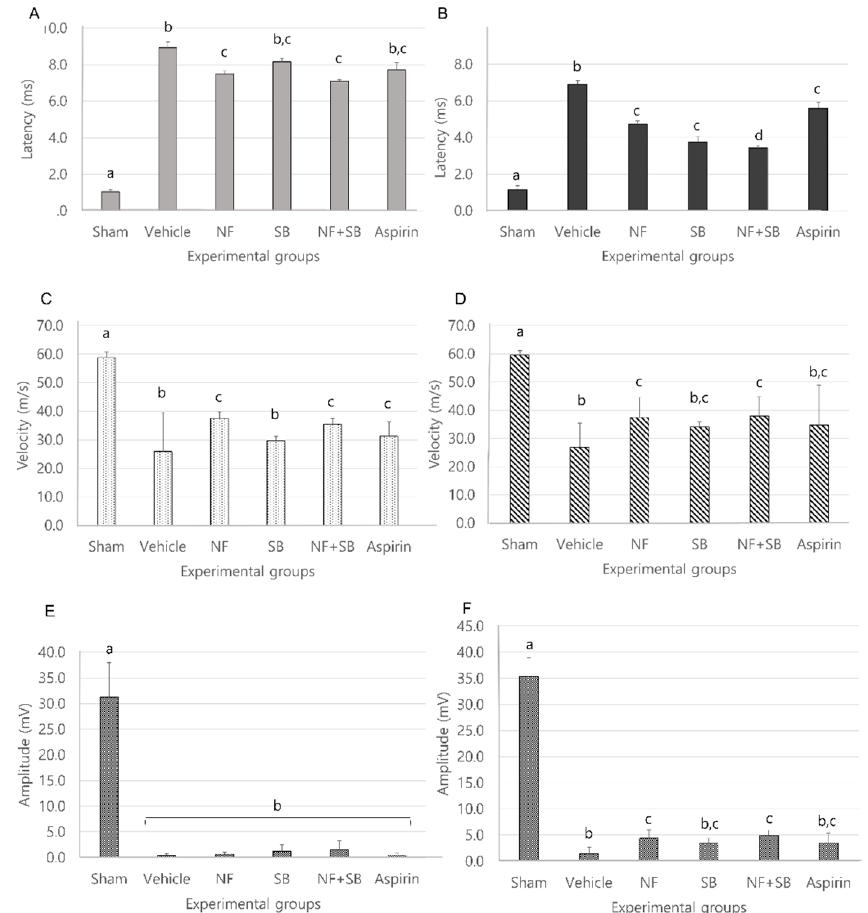
Figure 4. Effect of NF and NF + SB at the 7th and 14th day after nerve crush injury with latency, nerve conduction velocity and amplitude of compound action potential in each group. Latency of each group at 7th ( A ) and 14th day ( B ); NCV of each group at 7th ( C ) and 14th day ( D ); Amplitude of each group at 7th ( E ) and 14th ( F ) day. Results are represented as mean ± SEM. Data were analyzed by ANOVA with Tukey’s post hoc analyses; Values with the di ff erent small letters (a–c) are significantly di ff erent among six treated groups at p < 0.05.